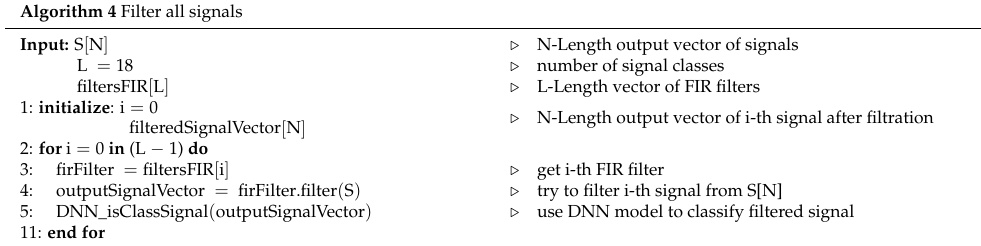
Algorithm 4 Filter all signals